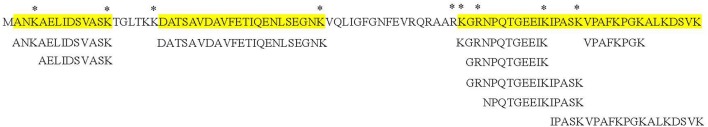
Covered residues of BM1122 by LC-MS/MS (highlight in yellow). * is the digestion sites of trypsin.